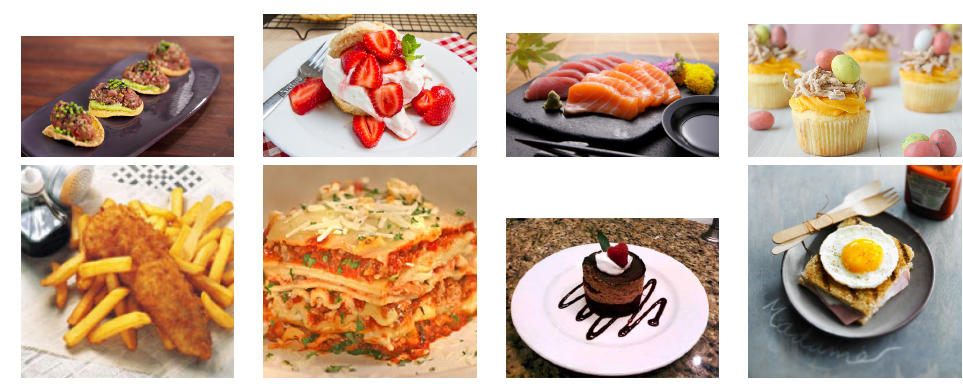
Figure 11. Images examples from the our cooking recipes